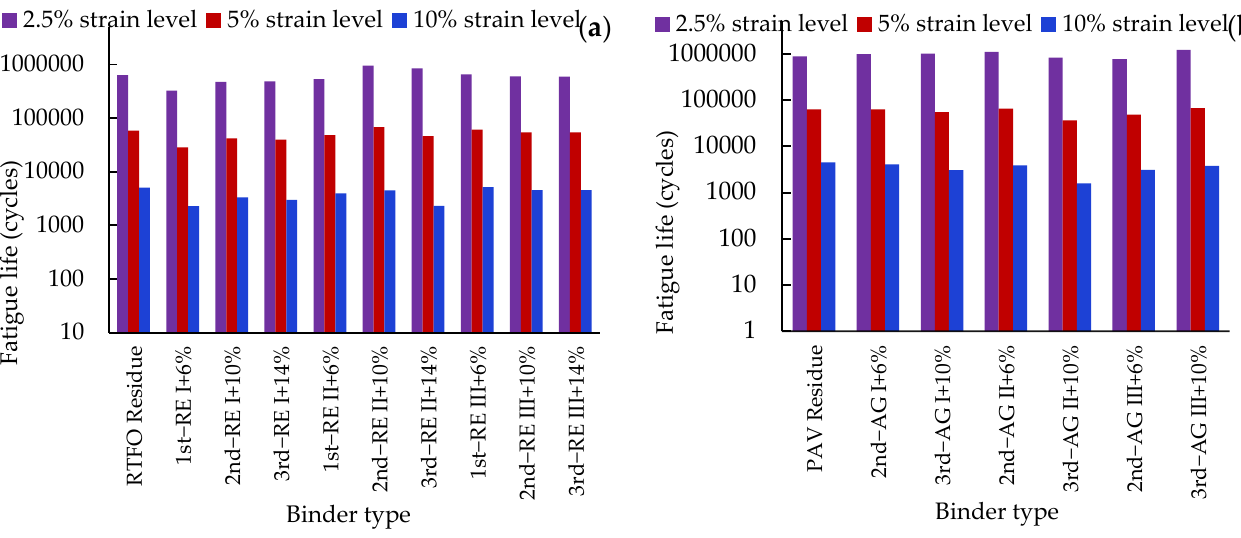
Figure 9. LAS fatigue life results: ( a ) rejuvenated asphalt-binders; ( b ) aged asphalt-binders.